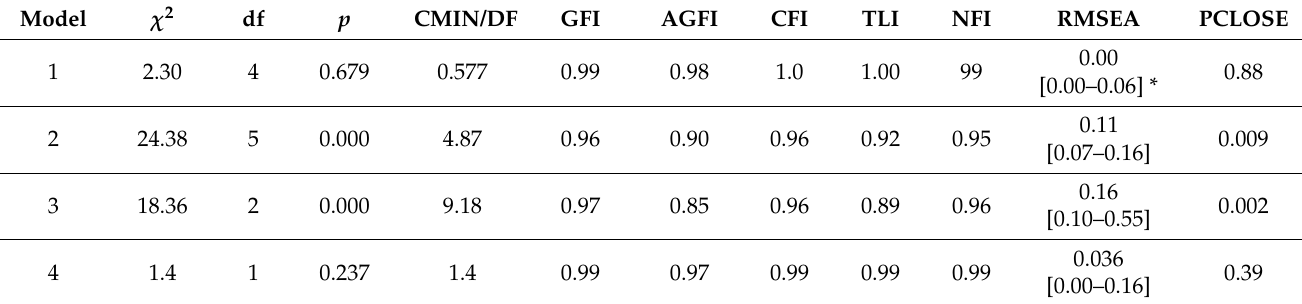
Table 2. Goodness-of-fit indices for Compulsory Temporary Afterlife Punishment Belief (CTAPB) in Study 2 ( N = 303).